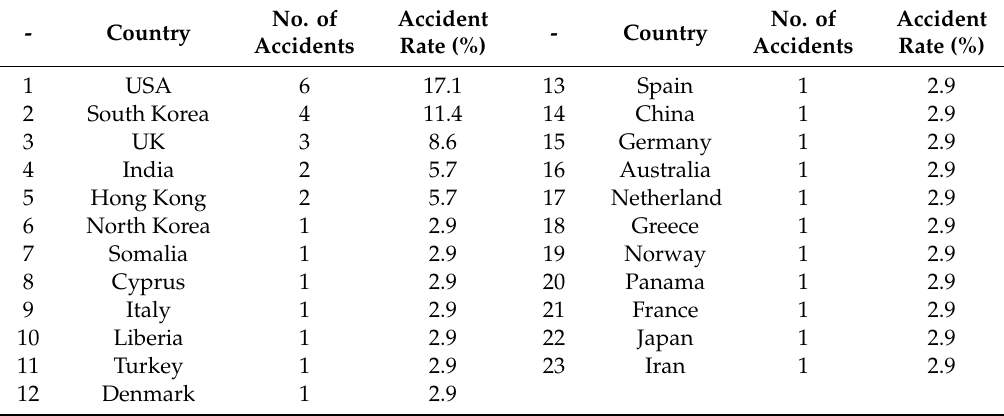
Table 1. The distribution of the accidents based on the vessels’ own